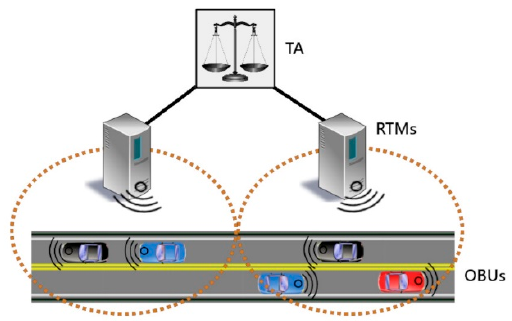
Figure 3. System diagram for proposed scheme.